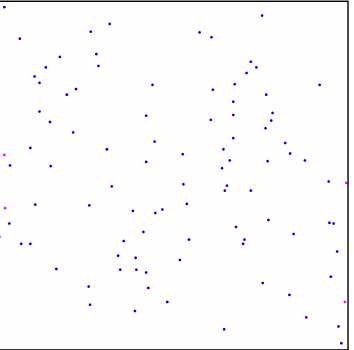
Figure 4. Sampling points obtained by random sampling principle.